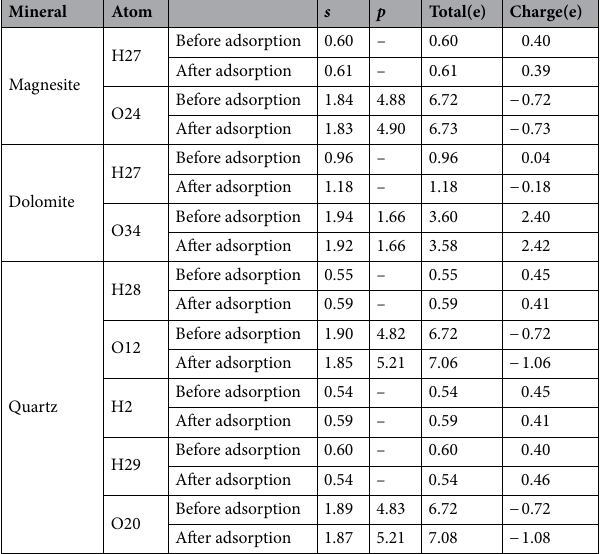
Table 4. NDA Mulliken population analysis on the surface of magnesite (101), dolomite (101) and quartz (101).